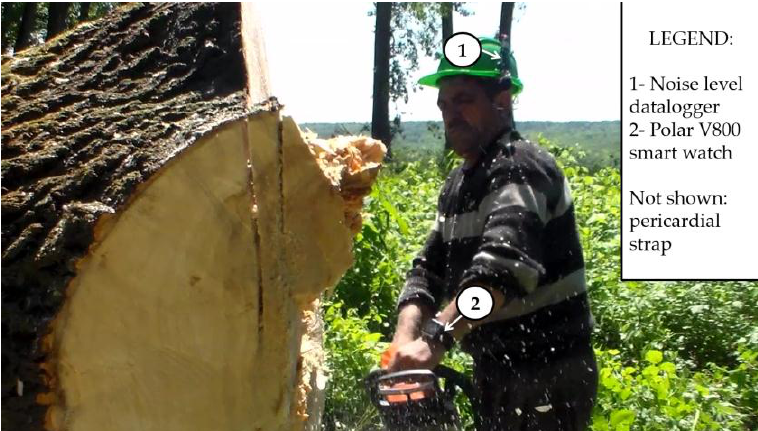
Figure 2. Placement of dataloggers on the feller.